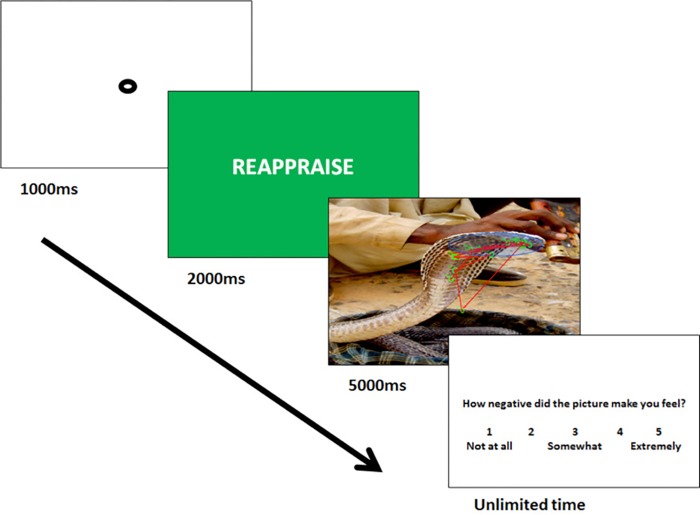
Example Trial Sequence with Eye Tracking Data and Emotional Interest Areas Depicted.The trial started with a 1000ms fixation, followed by a 200ms instruction cue (distract, reappraise, watch, view), a 5000ms IAPS stimulus presentation, and unlimited time for self-reported negative affect. The unpleasant image presented is a sample stimulus. It is not part of the IAPS library and was not included in the task. Actual IAPS images could not be displayed due to copyright limitations.